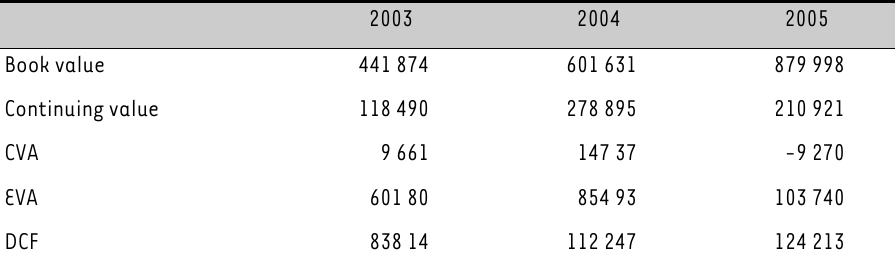
TABLE 6: Performance valuation results (thousands